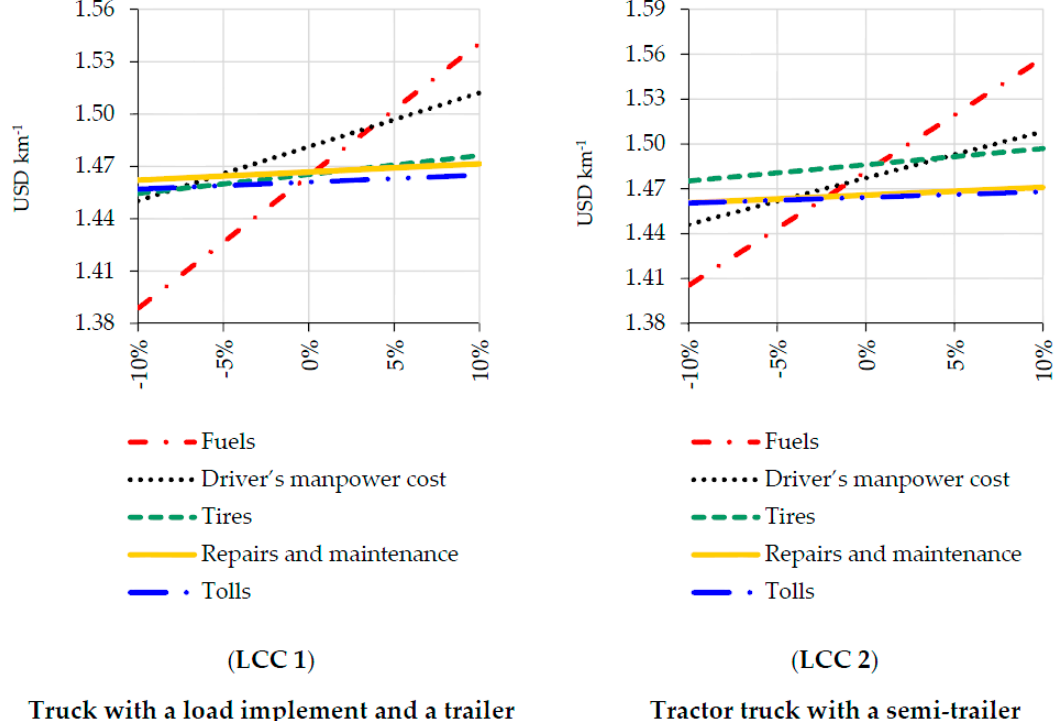
Figure 1. Modal value of the operational cost of transportation (USD km −1 ) versus the percentage change of the most relevant components.